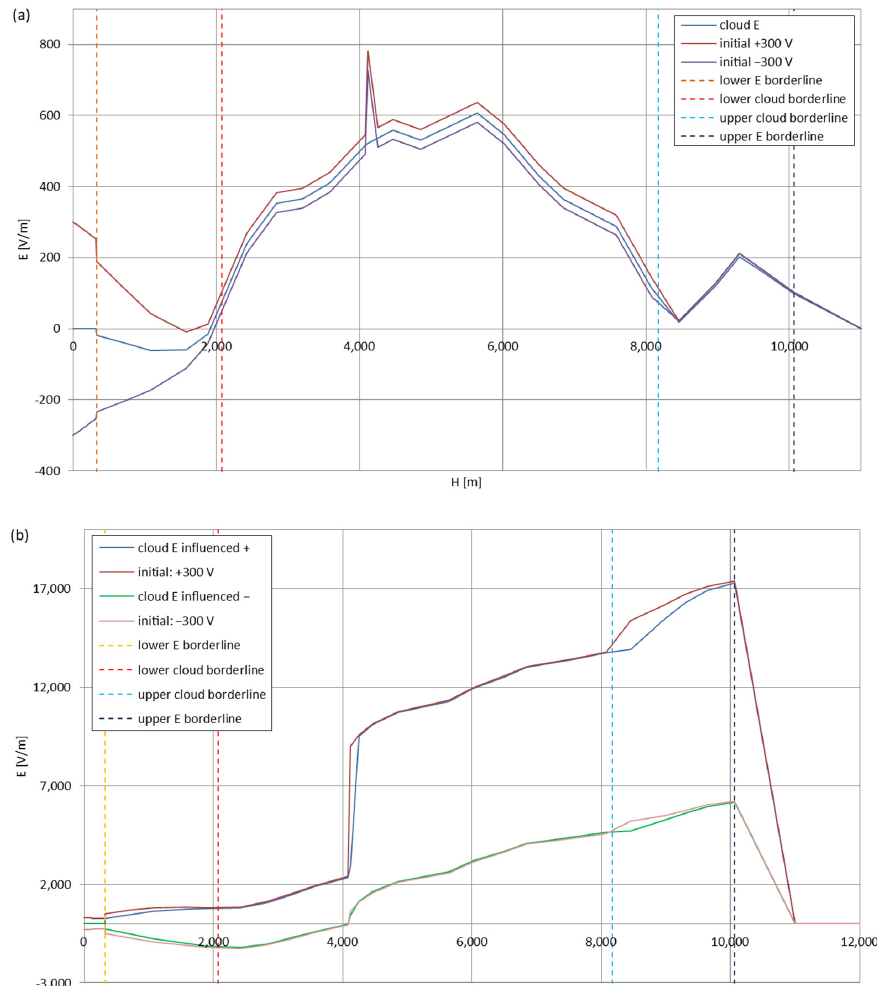
Figure 10. Maximum electric field strengths around the wire antenna passing through Nimbostratus cloud of mixed charge structure, Kyiv data: ( a ) ‘static’ case and ( b ) ‘dynamic’ case.